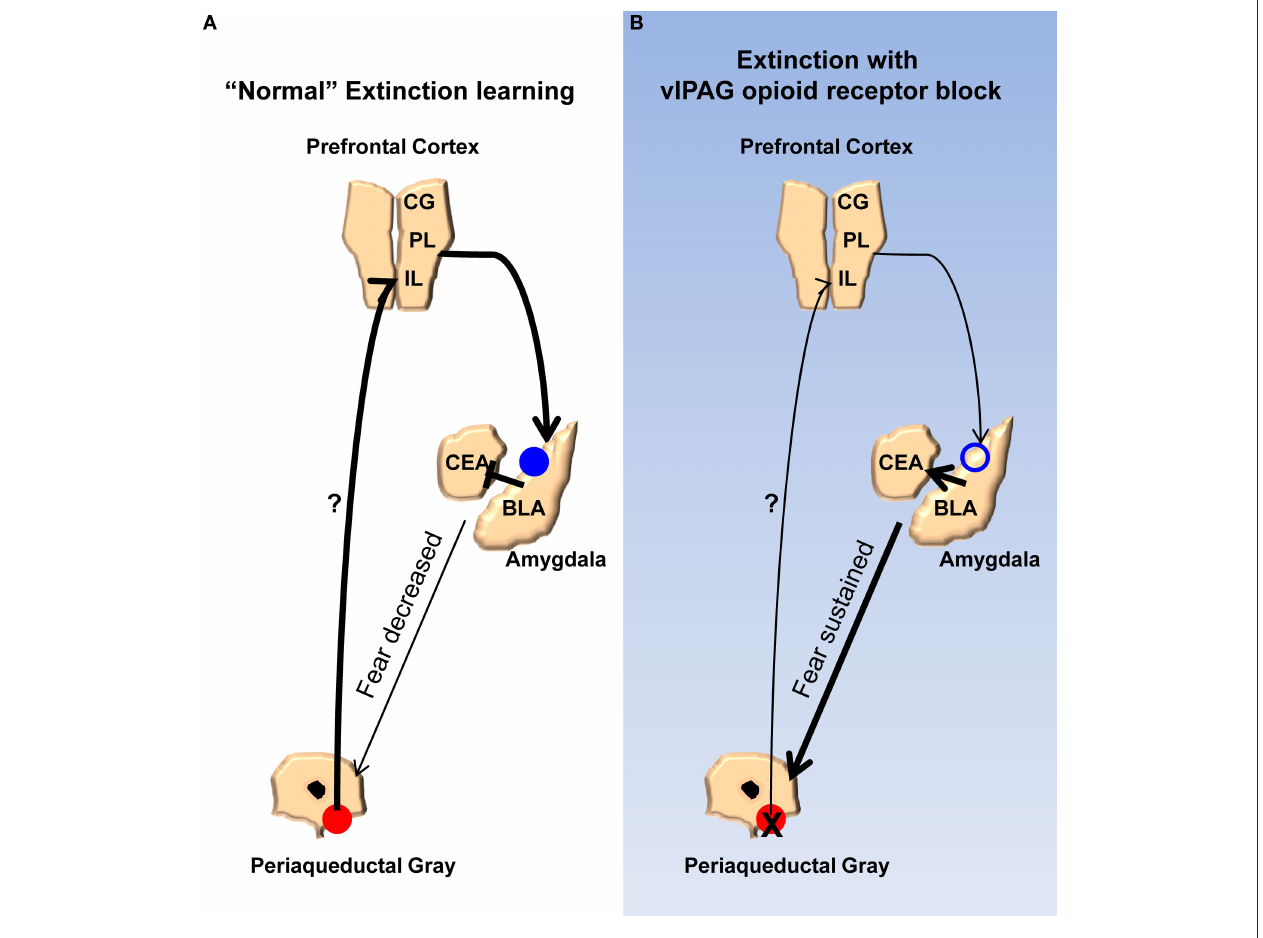
(ITC) of the amygdala. Enhancement of BLA/ITC activity results in an inhibition of the central nucleus of the amygdala and a decreased ability to produce fear responses. (B) When opioid receptors are blocked during extinction learning there is no change in excitability of the mPFC or the BLA/ITC, the output of the central nucleus is not affected, and fear responses are